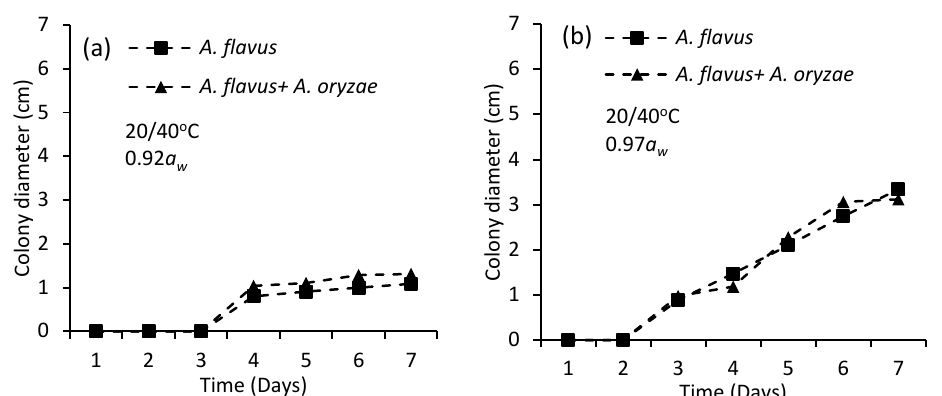
Figure 5. Growth of A. flavus inoculated in single and dual cultures with A. oryzae incubated under fluctuating temperatures of 20/40 °C with 15 h/9 h cycling time at ( a ) 0.92 a w and ( b ) 0.97 a w for 7 days on chili-based agar.